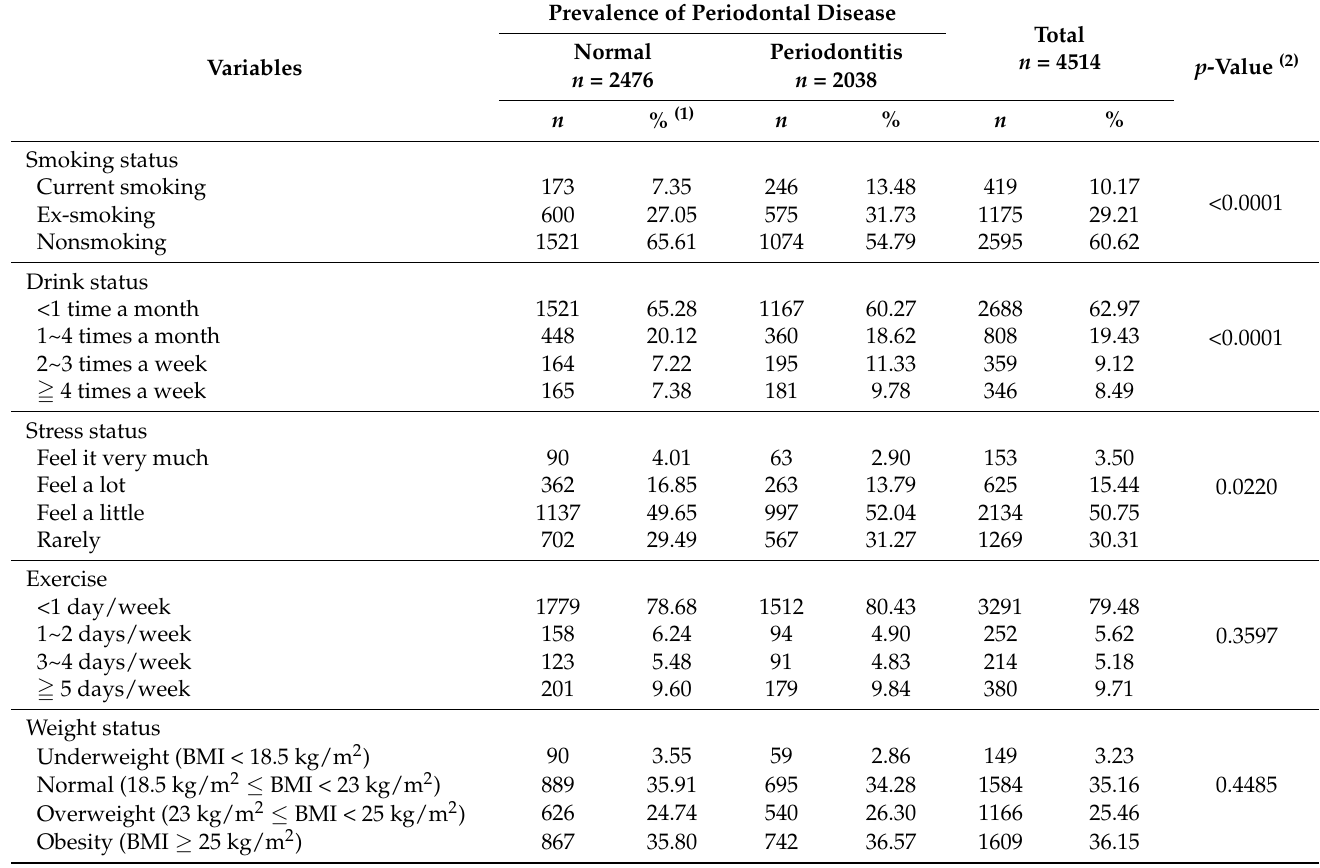
Table 2. Factors related to health according to prevalence of periodontitis in survey subjects.